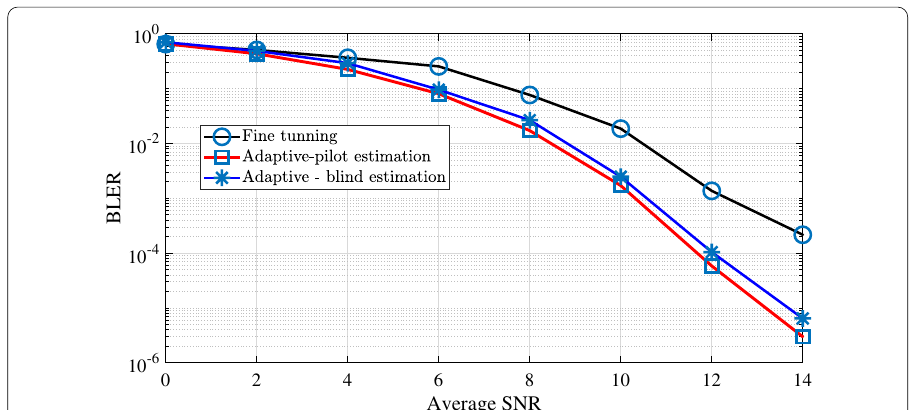
Fig. 5 Performance of the proposed AE-based systems versus fine tuning approach proposed in [2] over the lognormal fading